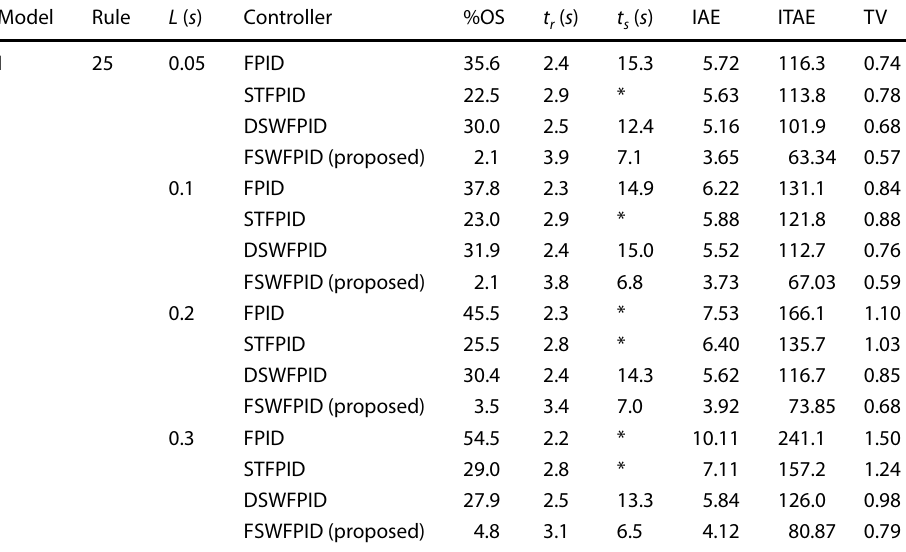
Table 6. The variation of weighting factor for DSWFPID